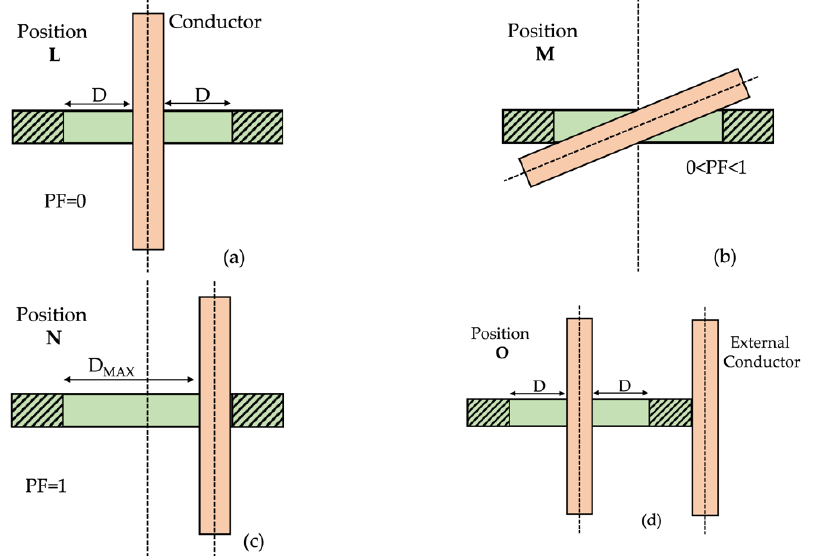
Figure 2. Four testing positions defined in [43] for RCs: ( a ) position L ( b ) position M ( c ) position N ( d ) position O.